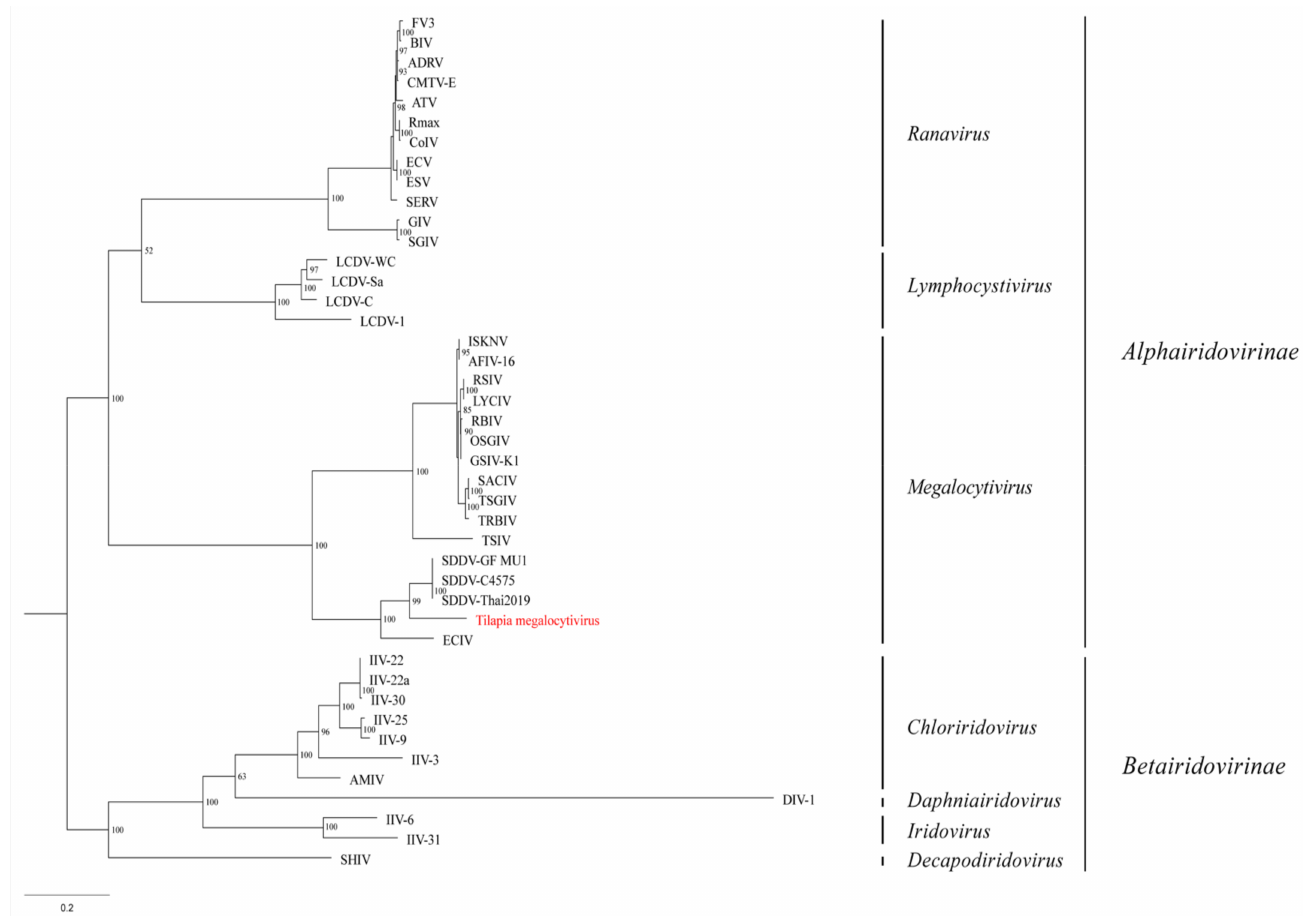
Figure 6. Phylogenetic tree displaying the relationship of the novel tilapia megalocytivirus to other iridoviruses based on the concatenated amino acid (AA) sequences of the major capsid protein and DNA polymerase genes (1117 AA characters including gaps). The maximum likelihood tree was generated using 1000 bootstraps with values included above each node. Branch lengths are based on the number of inferred substitutions, as indicated by the scale bar. See Supplementary Table S1 for virus abbreviations and GenBank accession